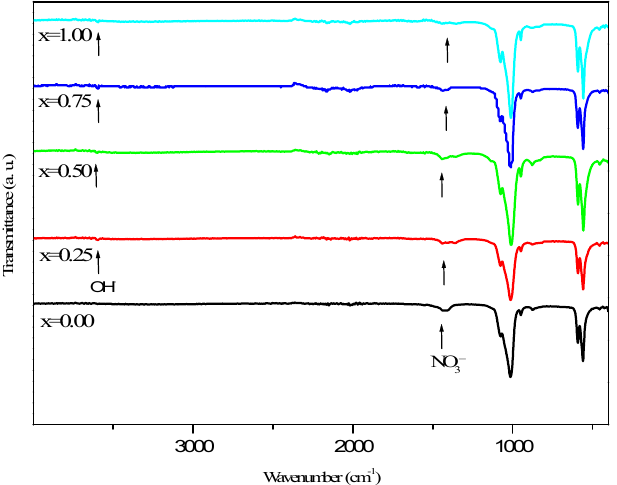
Figure 2. Infrared spectra of synthesized Ca 10 − x K x (PO 4 ) 6 F (2 − 2 x ) (OH) x for 0 ≤ x ≤ 1. Arrows indicate the traces of OH and nitrates.